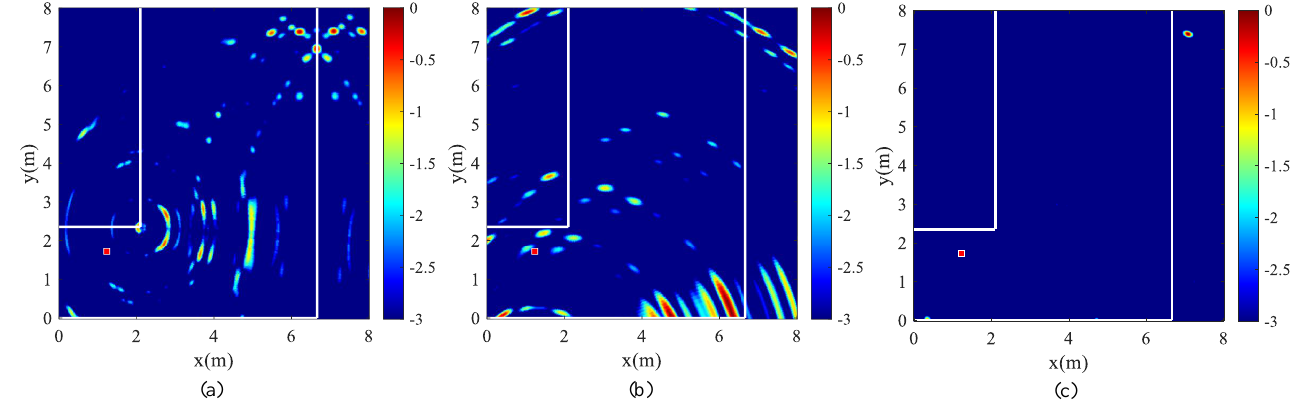
Figure 14. Multipath imaging results via dual-view in targetless scenario. ( a ) Imaging result of Path -1, Path -3 and Path -5 through range profiles of View 1. ( b ) Imaging result of Path -2 and Path -6 through range profiles of View 2. ( c ) Fusion of ( a , b